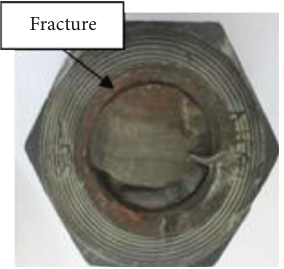
Figure 3: Morphology of bolt fracture. Table 1: Results of mechanical property test.